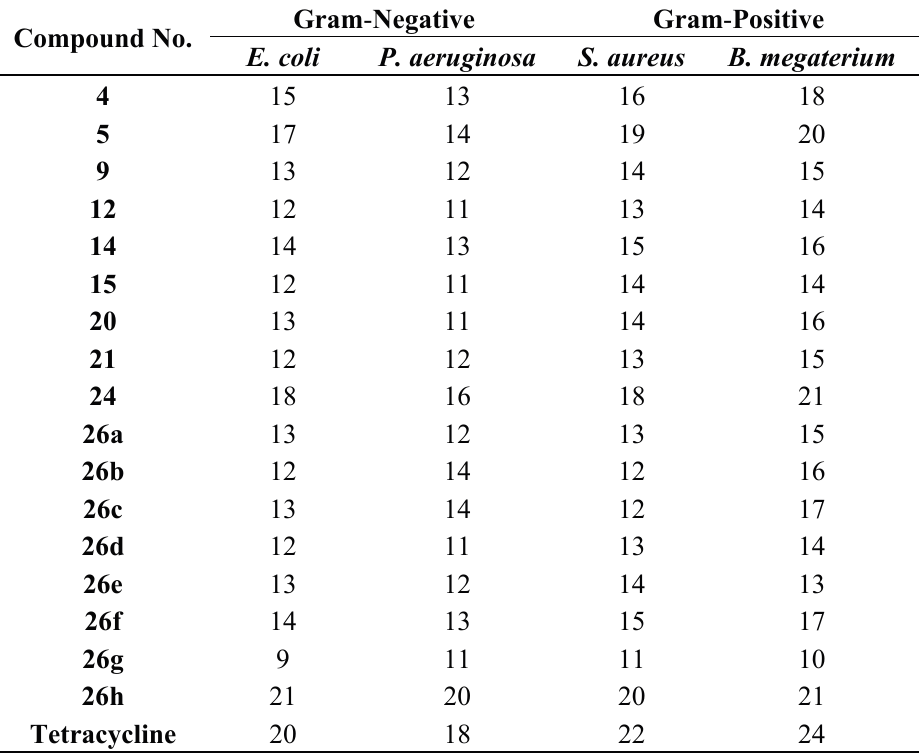
Table 1. Effect of compounds on Gram-negative and Gram-positive microorganisms. Results expressed as inhibition zone diameter in mm. Compound